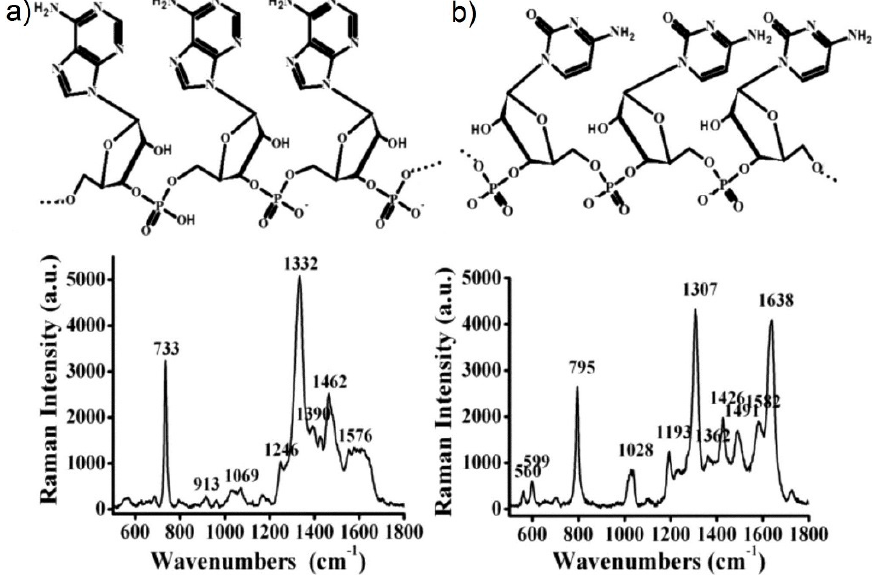
Figure 45. Structures and SERS spectra of single-strand polyadenosine (pA, 10 mers, at 1 nmol) ( a ) and single strand polycytidine (pC, 10 mers, at 2 nmol) ( b ) (conditions of acquisition: λ ex = 514.5 nm, time 60 s, and laser power = 10 mW at the sample). The purine base, pA, exhibits two major peaks at 733 cm − 1 (ring breathing) and 1332 cm − 1 , assigned to the ring stretching mode that can be used as marker bands. The pyrimidin base exhibits the ring breathing mode and the ring stretching mode, at 795 and 1307 cm − 1 , respectively, and 1636 cm − 1 band assigned to the C=O vibration. Reproduced with permission from Prado et al. [451]. Copyright (2014), the American Chemical Society.